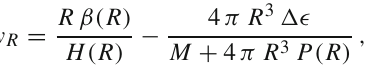
Fig. 1 The relation between energy per baryon and baryon number density. The black-dashed line represents this relation for the EOS of ordinary nuclear matter described by CLDM